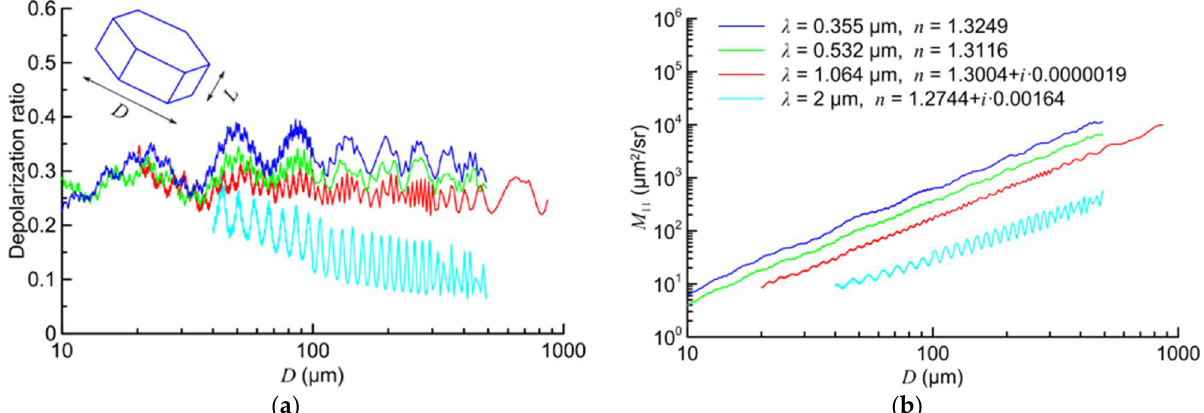
M ( b ) for hexagonal plate at 11